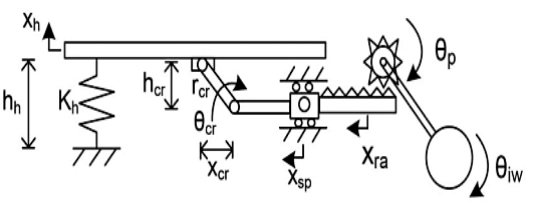
Figure 20. Lever system [43].